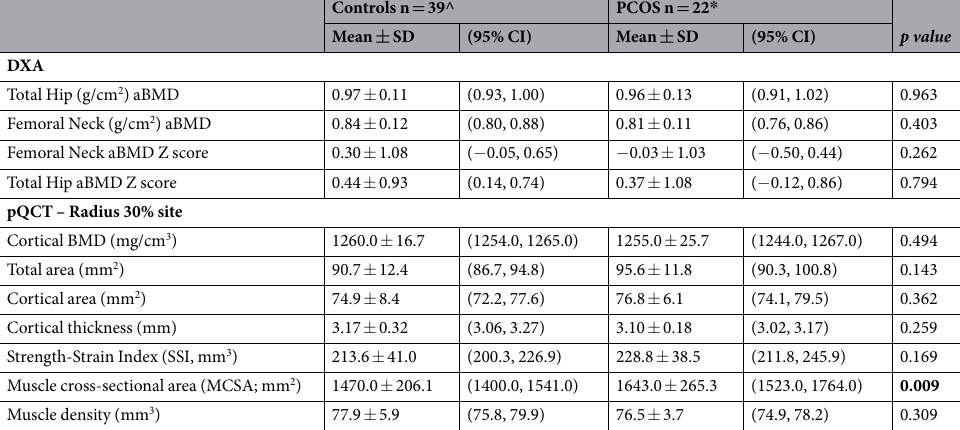
Controls (n = 39) PCOS (n = 22) Total Hip BMD Spearman r p value